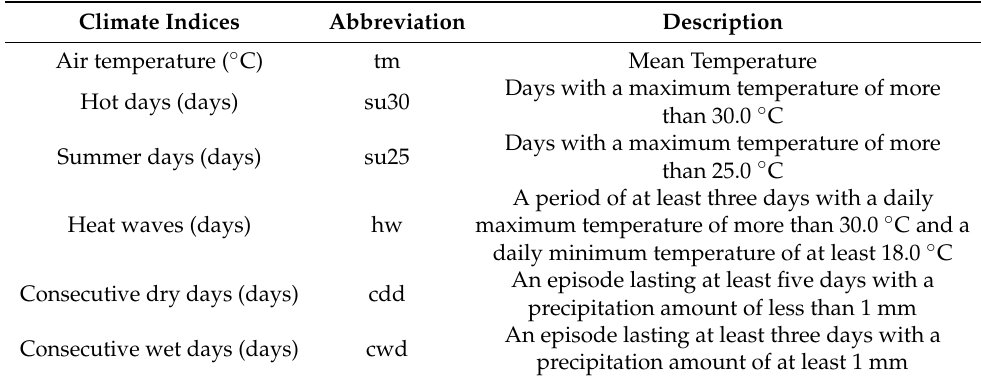
Table 1. Significant climate indices